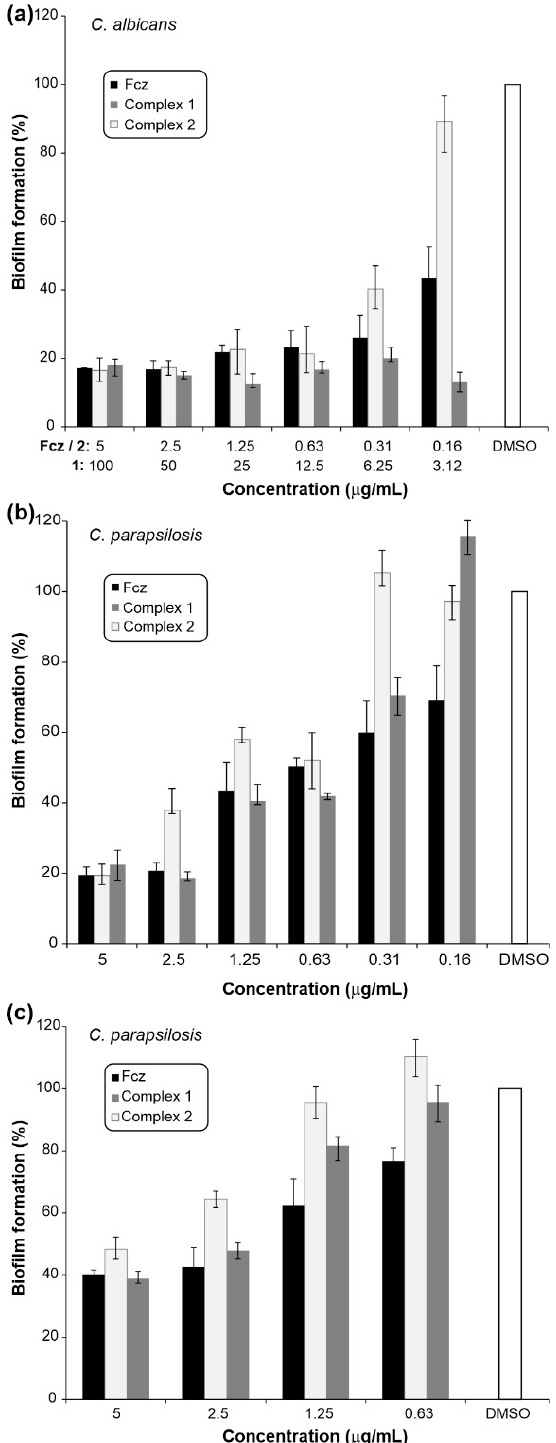
Figure 5. The effect of fluconazole and complexes 1 and 2 on the biofilm formation and eradication. Percentage of formed biofilm of C. albicans ATCC 10231 ( a ) and C. parapsilosis ATCC 22019 ( b ) in the presence of complexes 1 and 2 and fluconazole and remaining C. parapsilosis biofilms treated with complexes 1 and 2 and fluconazole ( c ).